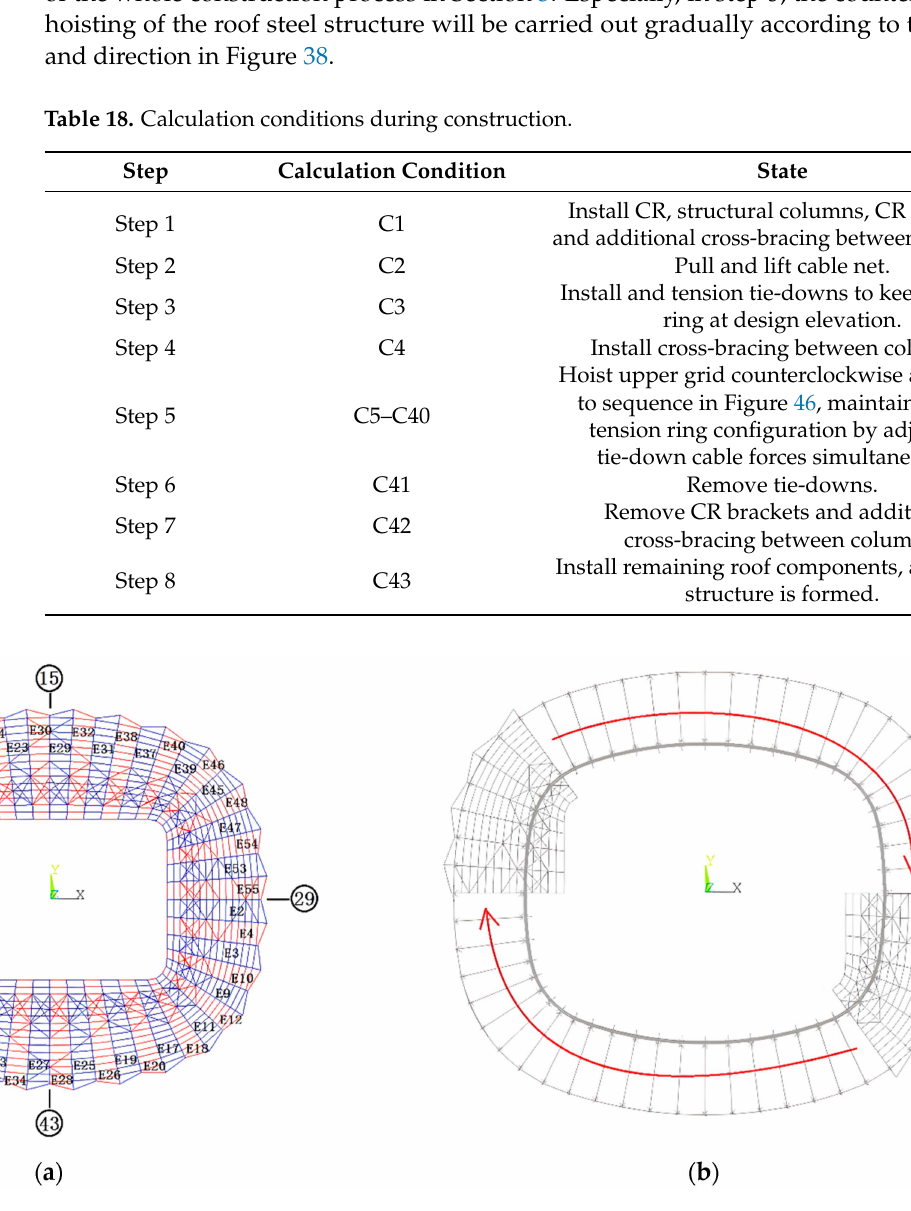
Figure 46. Grid hoisting steps: ( a ) installation section diagram (blue and red indicate hoisting and closure units, respectively; E1, E2, E3, . . . E56 are codes of 56 units, marked according to specific assembly sequence; 1,15,29,43 represent the main axis.); ( b ) installation sequence